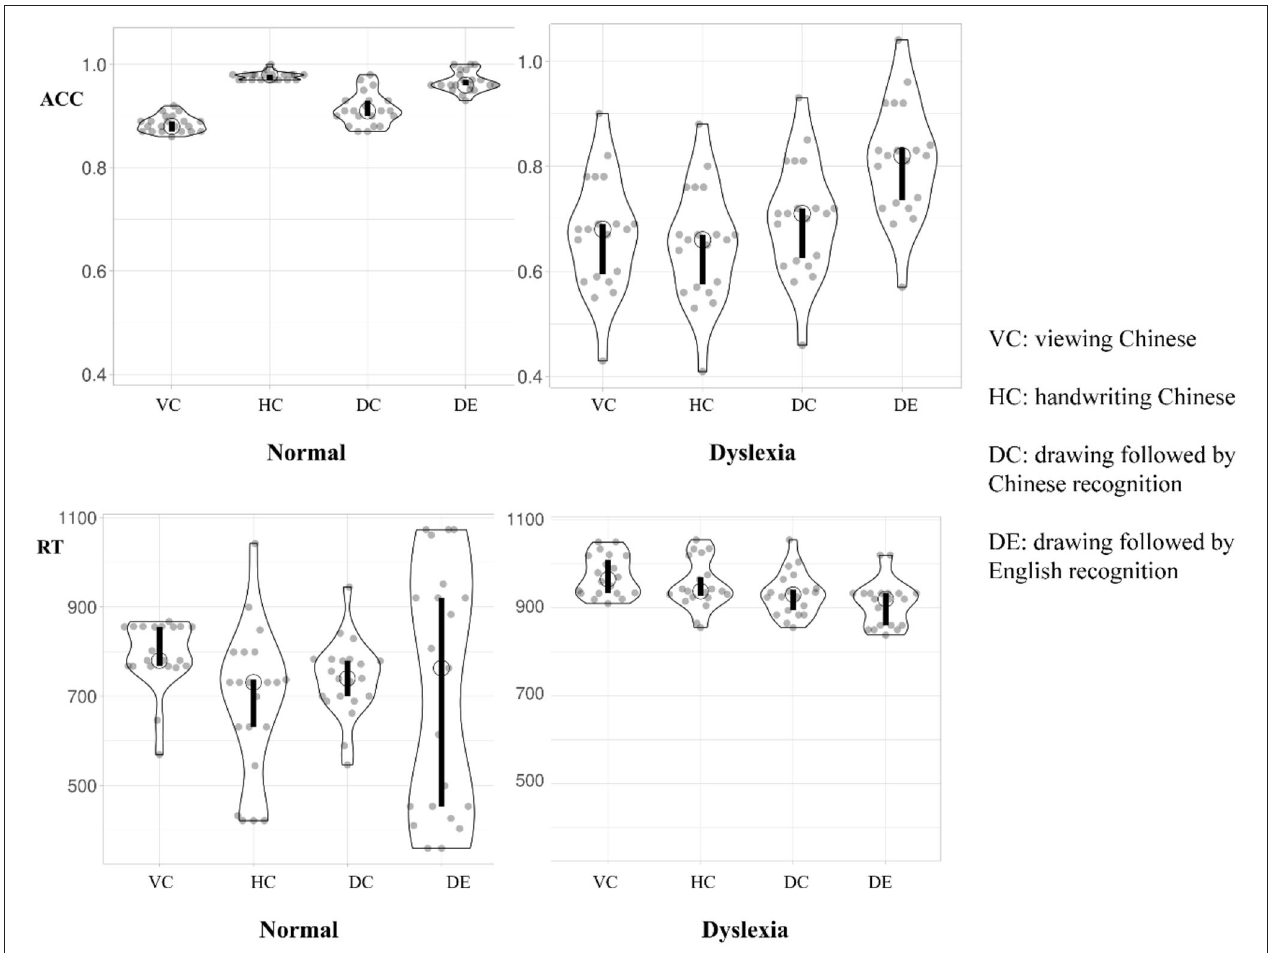
FIGURE 2 | Behavioral data of normal readers and dyslexic children. Open circle indicates the median in each condition. Bar chart indicates the 95% confidence interval for each median determined by bootstrapping.